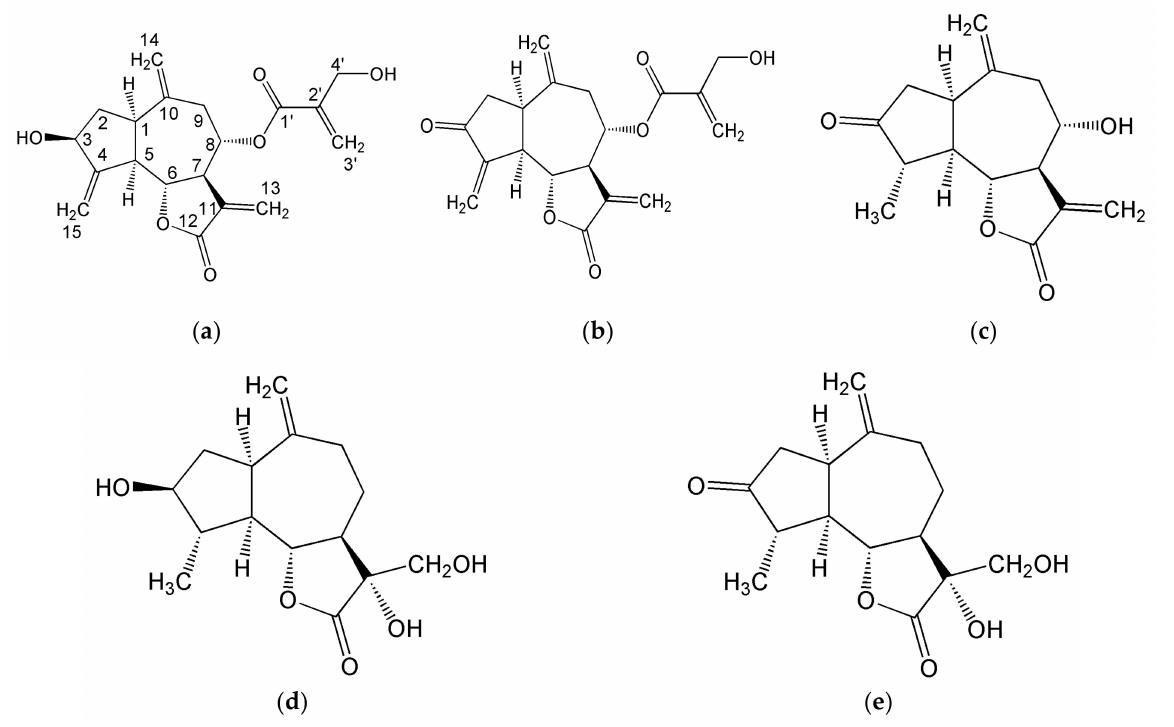
Figure 2. Structures of sesquiterpene lactones: ( a ) cynaropicrin; ( b ) dehydrocynaropicrin; ( c ) grosheimin; ( d ) cynaratriol; ( e )